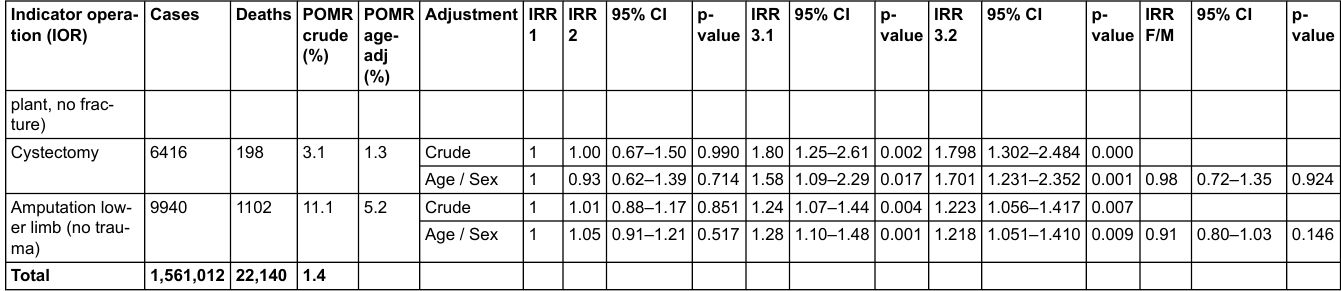
porting process. Third, IOR data may have been signif-